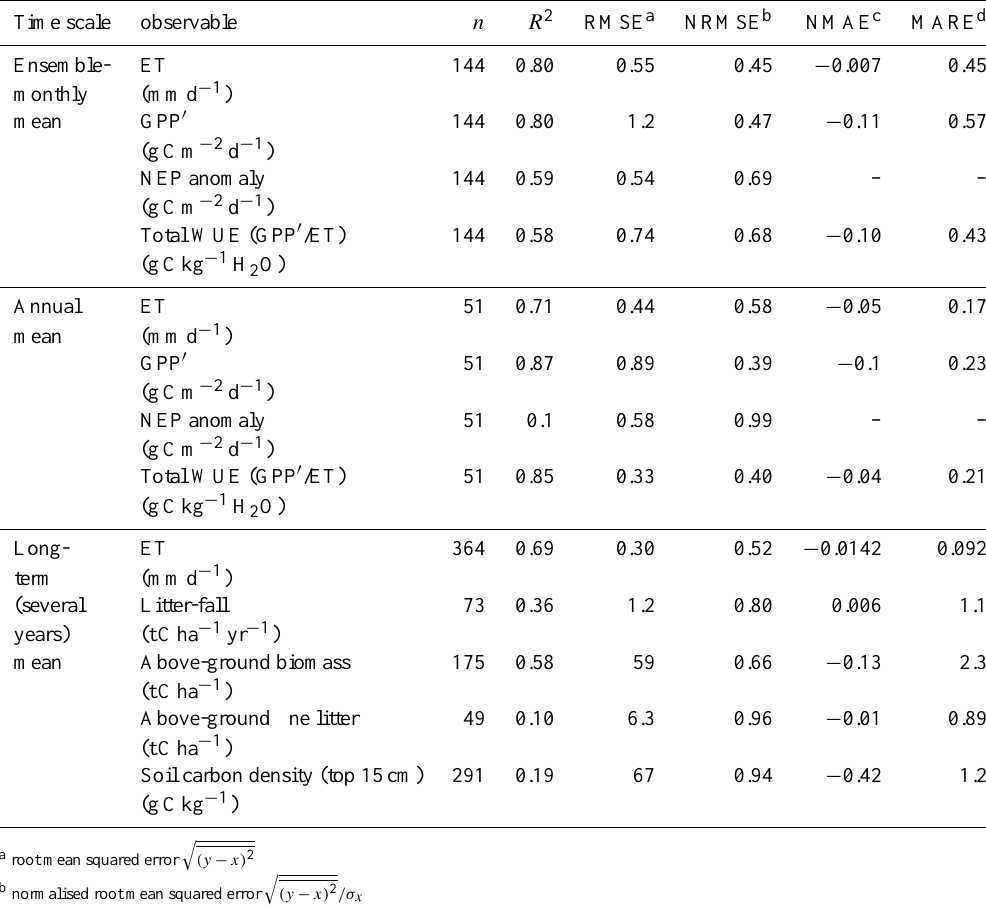
Table 2. Statistics relating to scatterplots of BIOS2 predictions ( y ) vs. observations ( x ). Time scale observable n